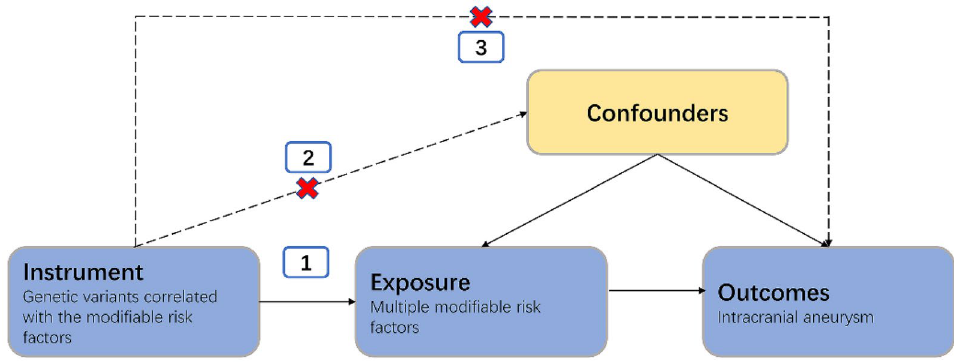
Figure 1. Schematic representation of Mendelian randomization analysis. Broken lines represent potential pleiotropic or direct causal effects between variables that would violate Mendelian randomization